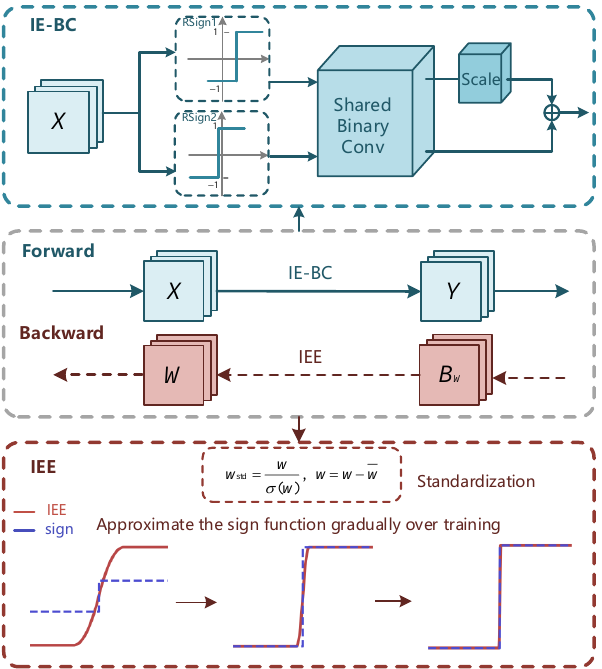
Figure 1. Overview of the proposed IE-Net. The information enhanced binary convolution (IE-BC) is used to enrich the information of binary activations and boost the representation power of binary convolution. The information enhanced estimator (IEE) is proposed to help maximize the information entropy of weights and minimize the quantization error to reduce the information